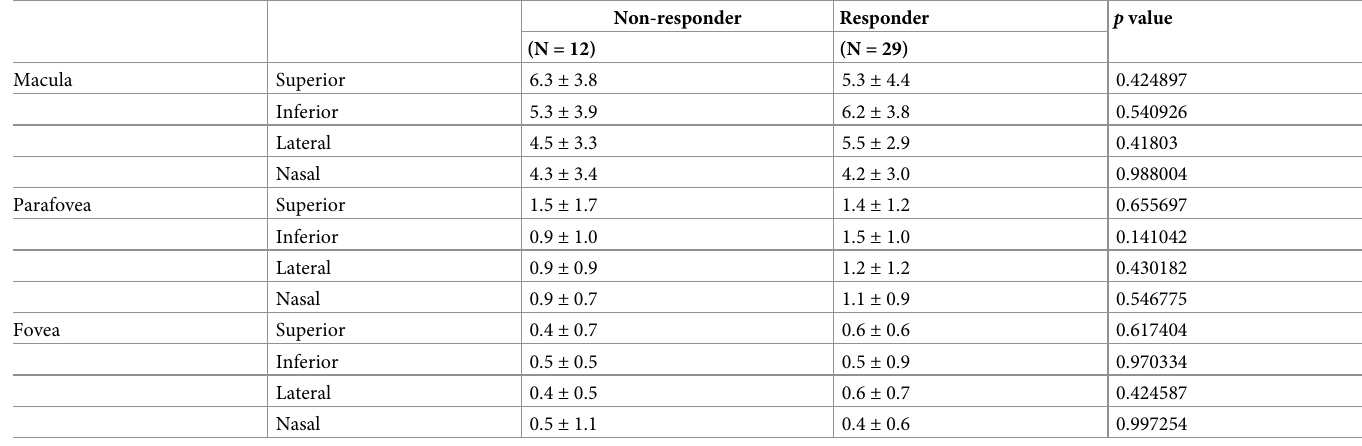
Table 5. Detected MA by